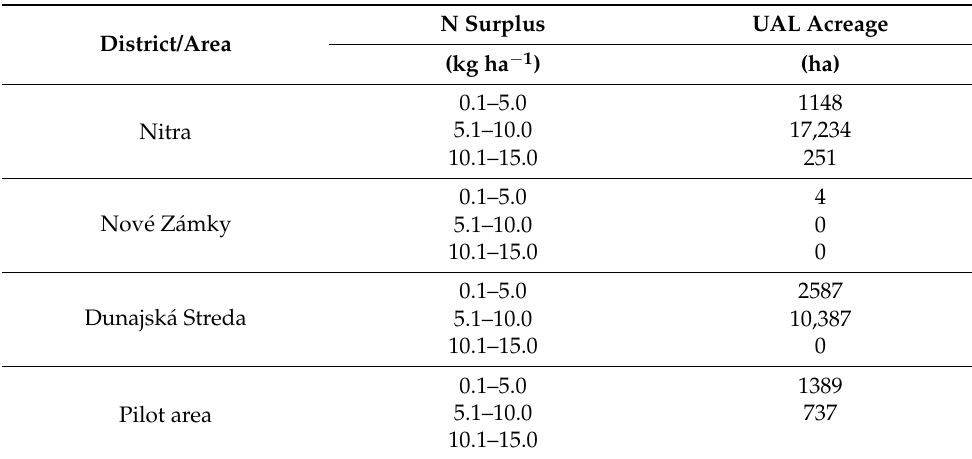
Table 6. The acreage of UAL which has to reduce the nitrogen surplus to ensure an average nitrate concentration in percolation water of 40 mg L − 1